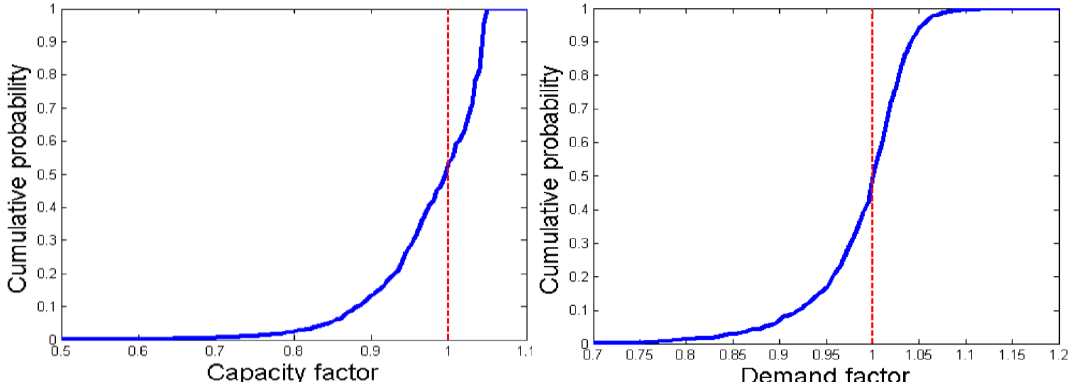
Figure 2. Cumulative distribution function of the road capactity and traffic demand